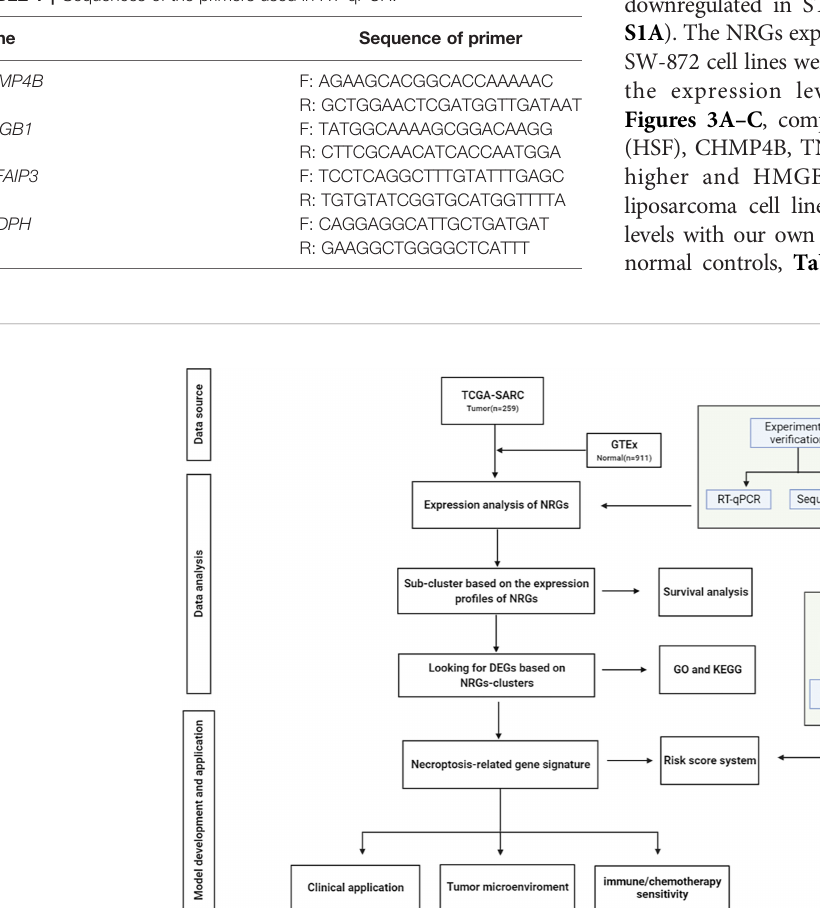
TABLE 1 | Sequences of the primers used in RT-qPCR.